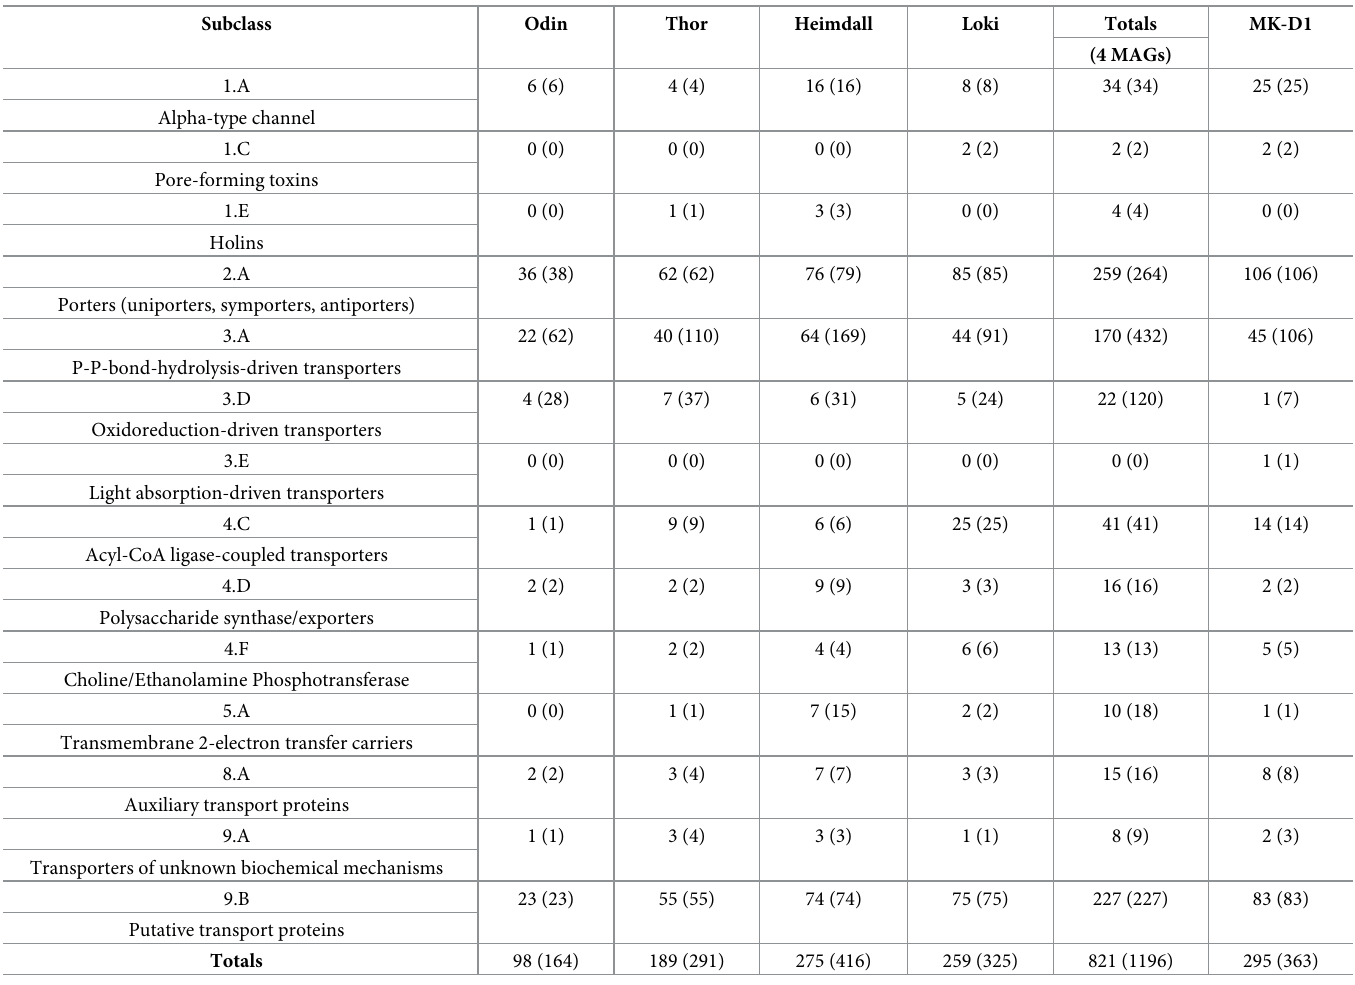
Table 2. Numbers of identified Asgard transport systems per TC